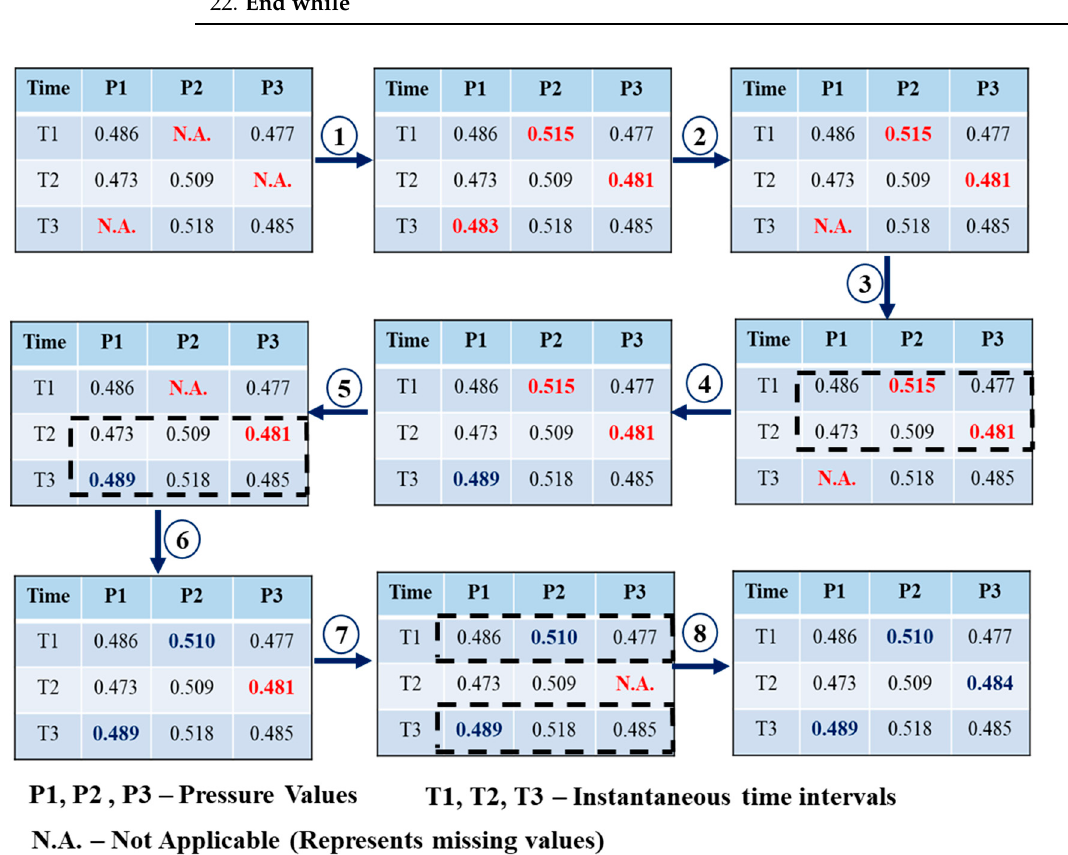
Figure 6. Workflow of multiple imputation by chained equations (MICE). The chained equation process is explained based on the MICE algorithm for a set of time series pressure values p 1 , …., p k . Assuming that some of the pressure values are miss- ing, all missing values are initially filled randomly or with the mean values.